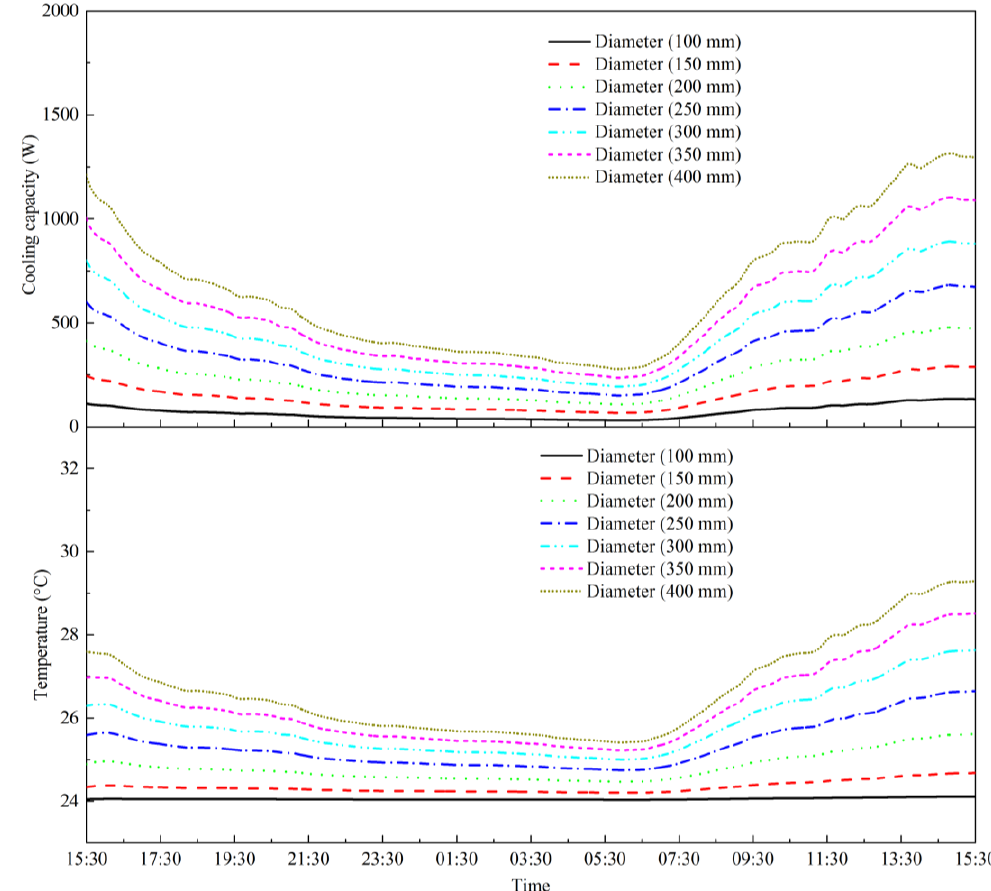
Figure 8. Evolution of outlet temperature and cooling capacity with respect to tube diameters.